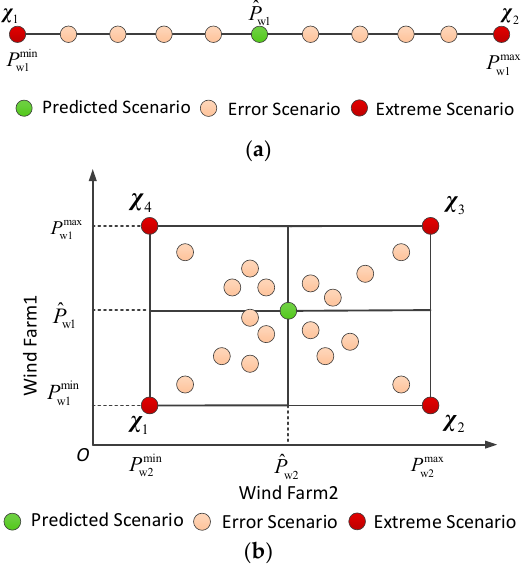
Figure 1. Schematic of the wind power output scenario space. ( a ) One wind farm; ( b ) Two wind farms. In Figure 1, P min and P max denotes the lower and upper bounds of confidence interval in a wind farm respectively, and ˆ P w is the arithmetic mean of P min w and max P w